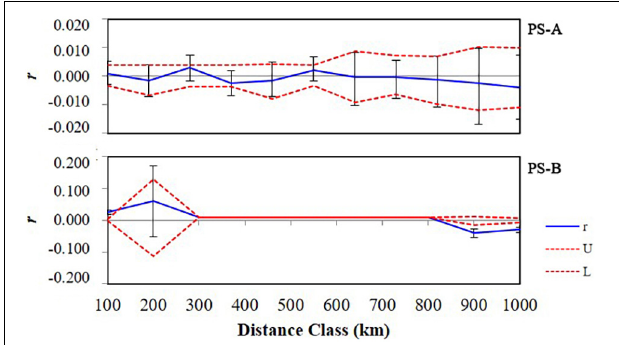
FIGURE 8 | Results of spatial autocorrelation analysis of the PS-A and PS-B Parantica sita clades. The blue line indicates the trend of spatial autocorrelation coefficient r , the red dotted lines indicate the 95% confidence interval boundaries (U, upper boundary; L, lower boundary).